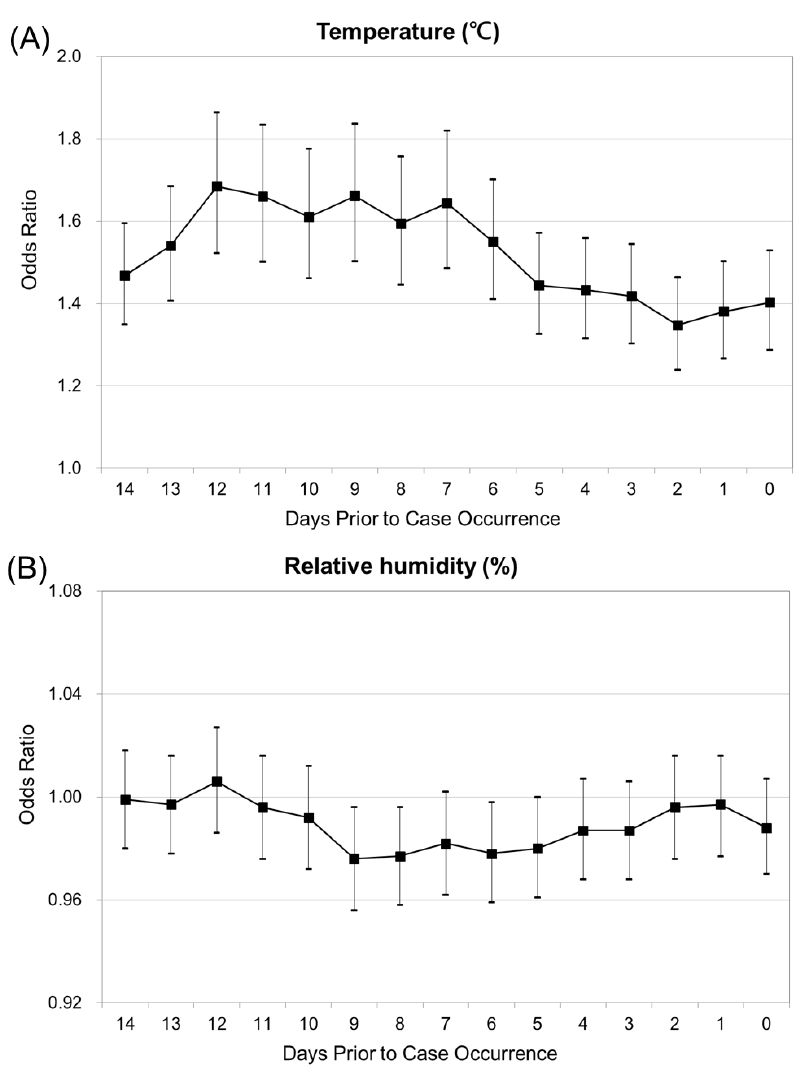
Figure 3. ( A ) Conditional logistic regression analysis for Japanese encephalitis, with temperature as explanatory variables. ( B ) Conditional logistic regression analysis for Japanese encephalitis, with relative humidity explanatory variables.